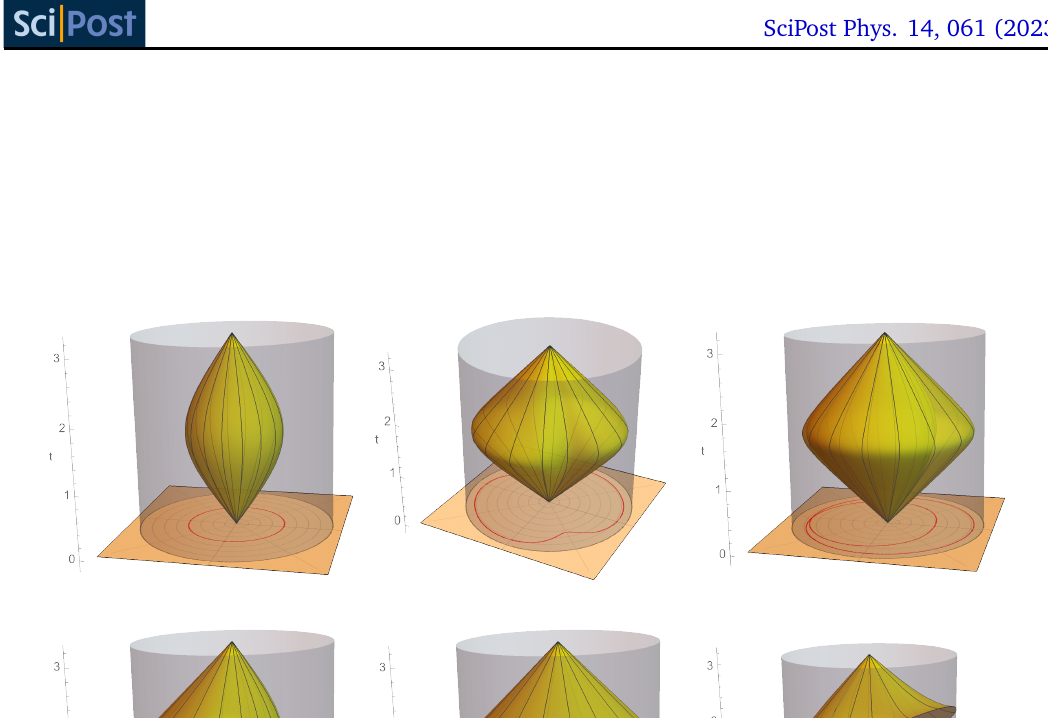
have self intersections (top right), reach out to touch the boundary (bottom left and middle), or even reach out to intersect the boundary (bottom right). The latter